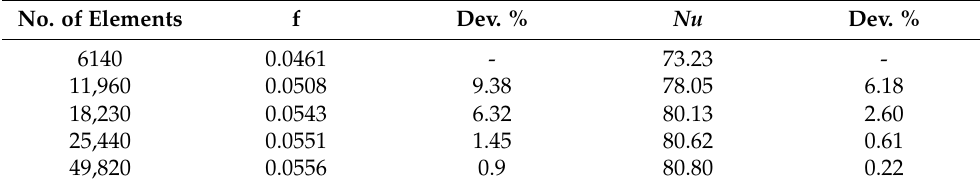
Table 2. Grid independent test for Re = 18,650 and insert diameter D =